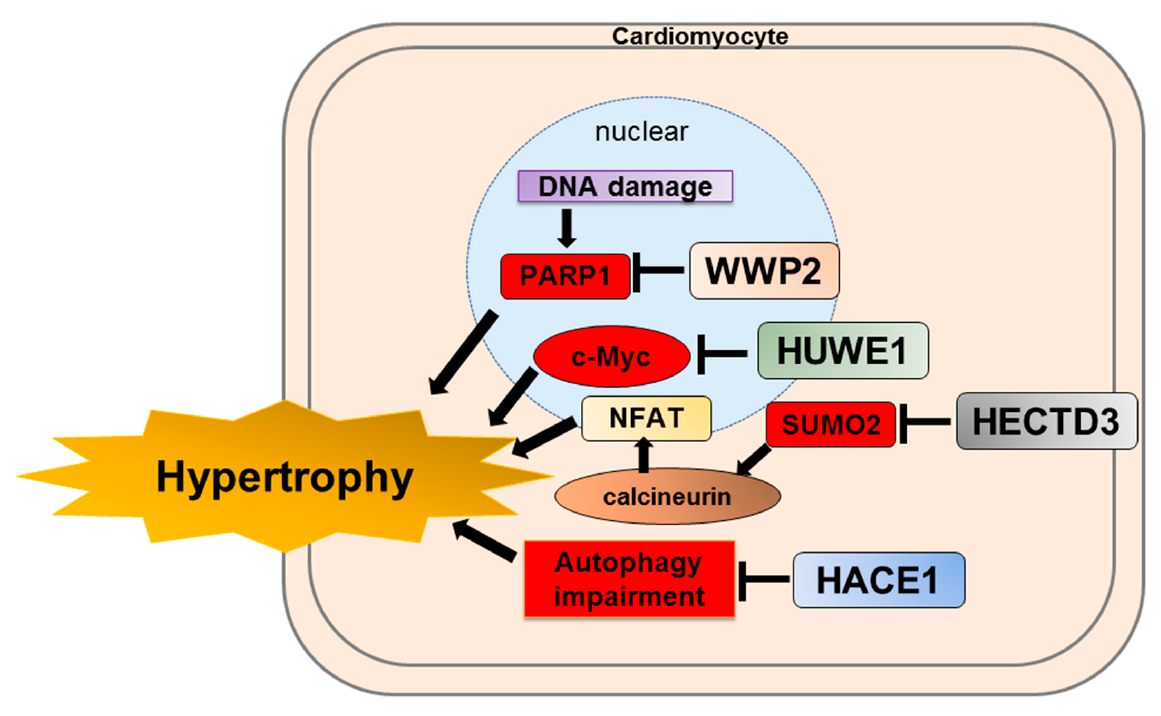
Figure 3. Schematics depicting the protective role of HECT-type E3 ligases for cardiac hypertrophy. WWP2 targets PARP1 for ubiquitin-proteasome degradation. HUWE1 targets c-Myc for ubiquitin–proteasome degradation. HECTD3 targets SUMO2 for ubiquitin–proteasome degradation. HACE1 ameliorates autophagy impairment. These HECT-type E3 ligases are a protective role for cardiac hypertrophy. WWP2, WW domain-containing E3 ubiquitin protein ligase 2; PARP1, Poly (ADP-ribose) polymerase-1; HUWE1, HECT, UBA, and WWE domain containing E3 ubiquitin protein ligase 1; HECTD3, HECT domain E3 ubiquitin protein ligase 3; SUMO2, small ubiquitin-like modifier 2; NFAT, nuclear factor of activated T-cells; HACE1, HECT domain and ankyrin repeat containing E3 ubiquitin protein ligase